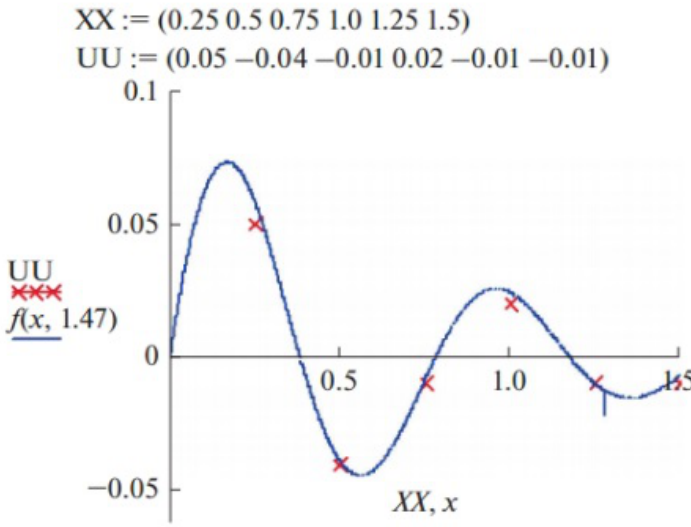
Figure 4. Deviation function (11) with parametric identification.